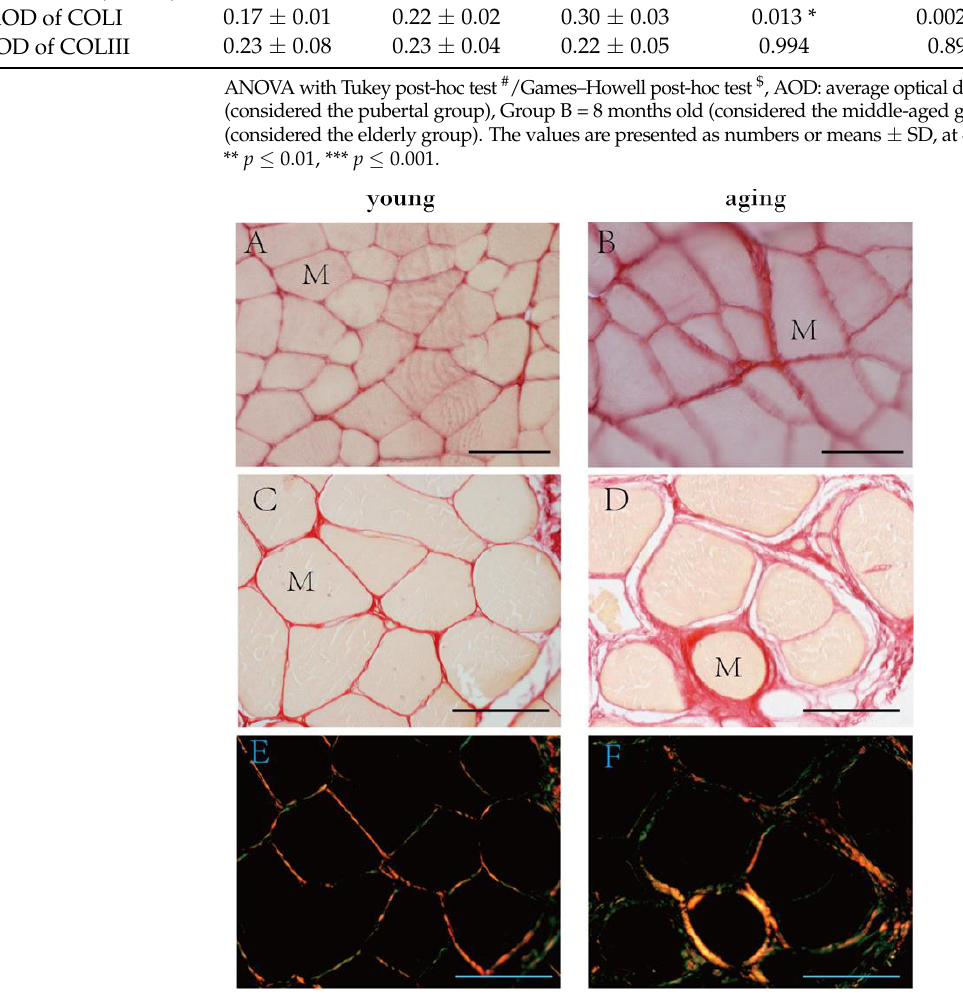
Figure 6. Picrosirius red staining of mouse ( A , B ) and human muscle samples ( C – F ) and polarized light images in human samples ( E , F ). ( A ): muscle sample from 6 week old mice (puberty, Group A), ( B ): from 2 year old mice (elderly, Group C); ( C , E ): muscle sample from a 32 year old human patient; ( D , F ): muscle sample from an 87 year old human patient. M = muscle cell. Scale bar: 50 μm.